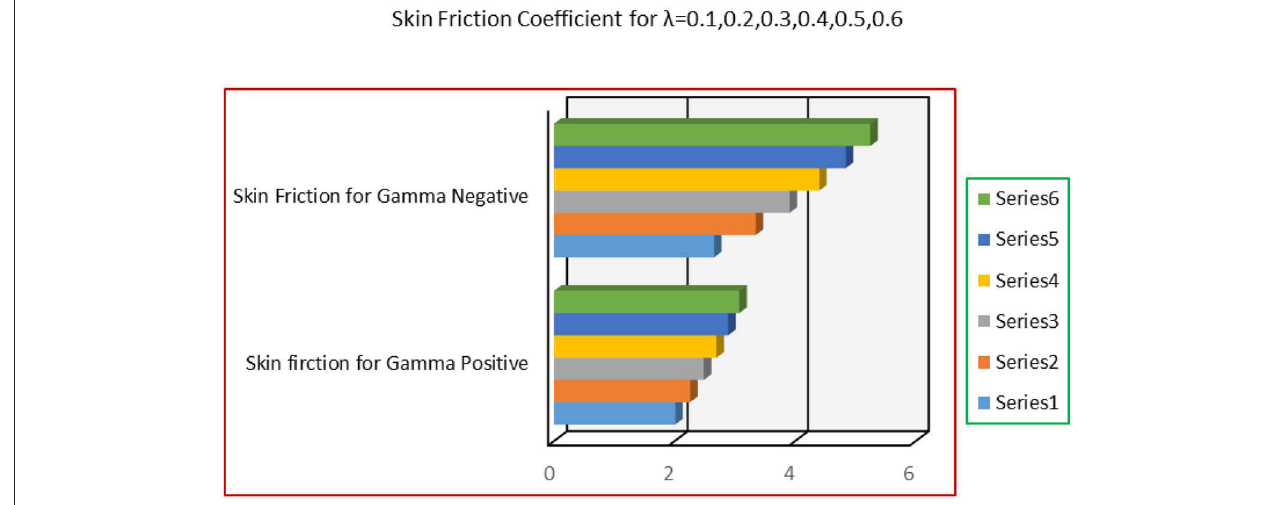
FIGURE 11 | The effects of λ on skin friction coefficient.